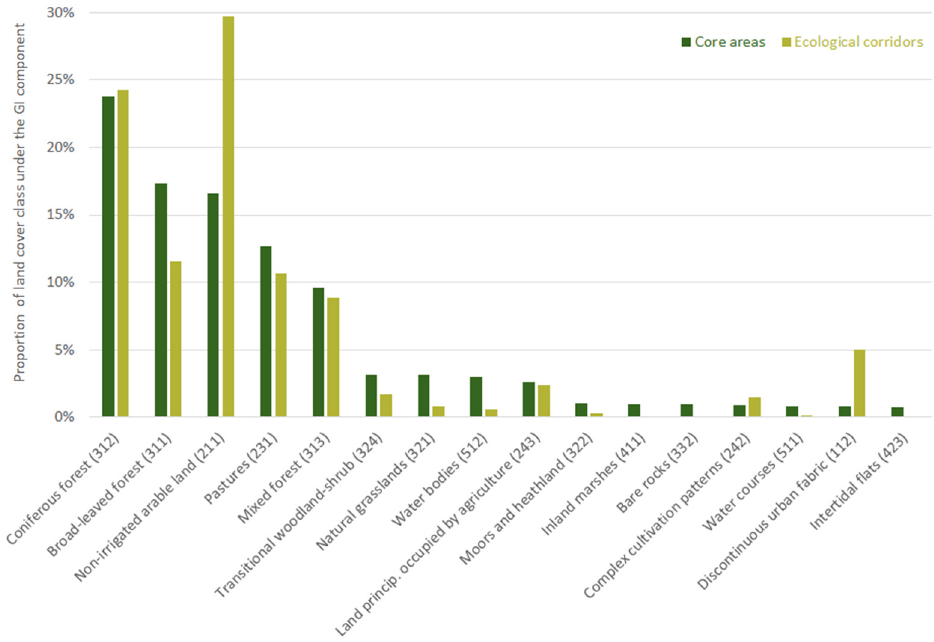
Figure 6. Proportion of the 16 most represented CLC classes under components of the GI network. Core areas are dark colour and ecological corridors light colour.